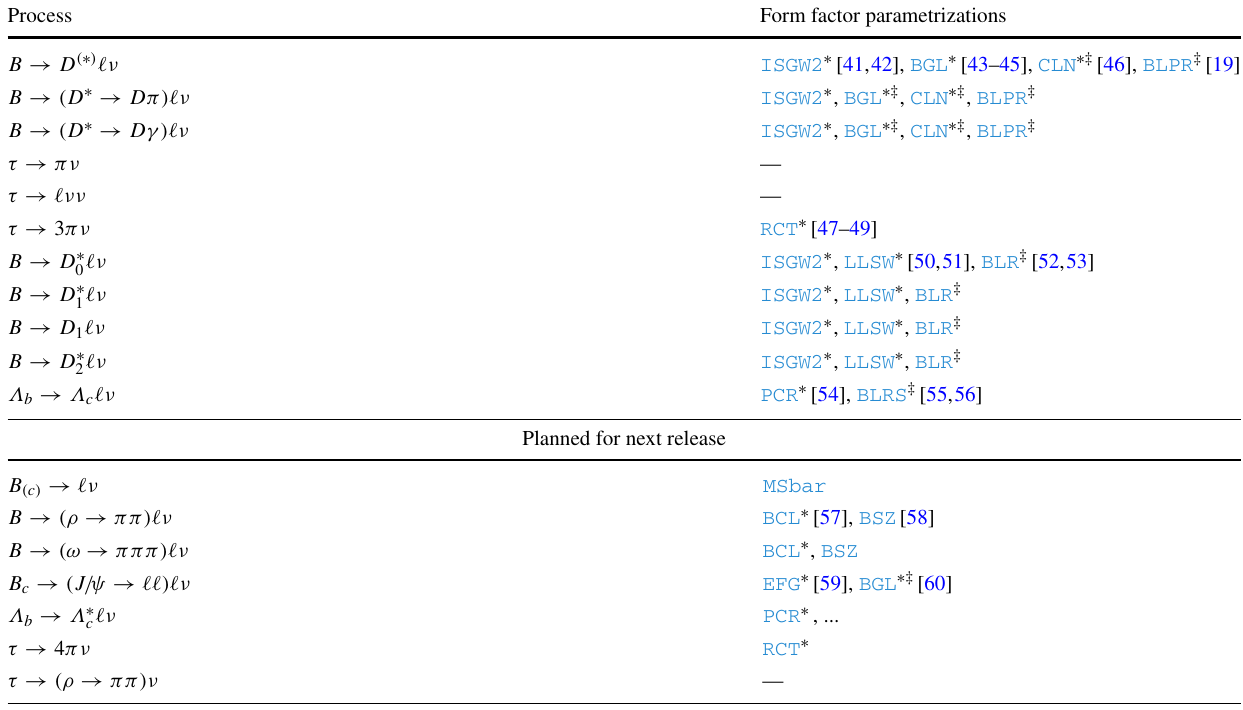
Table 3 Presently implemented amplitudes in the Hammer library, include linearized variations are denoted with a ‡ superscript. These are and corresponding form factor parametrizations. SM-only parametriza- named in the library by adding a “ Var ” suffix, e.g. “ BGLVar ” tions are indicated by a ∗ superscript. Form factor parametrizations that Process Form factor